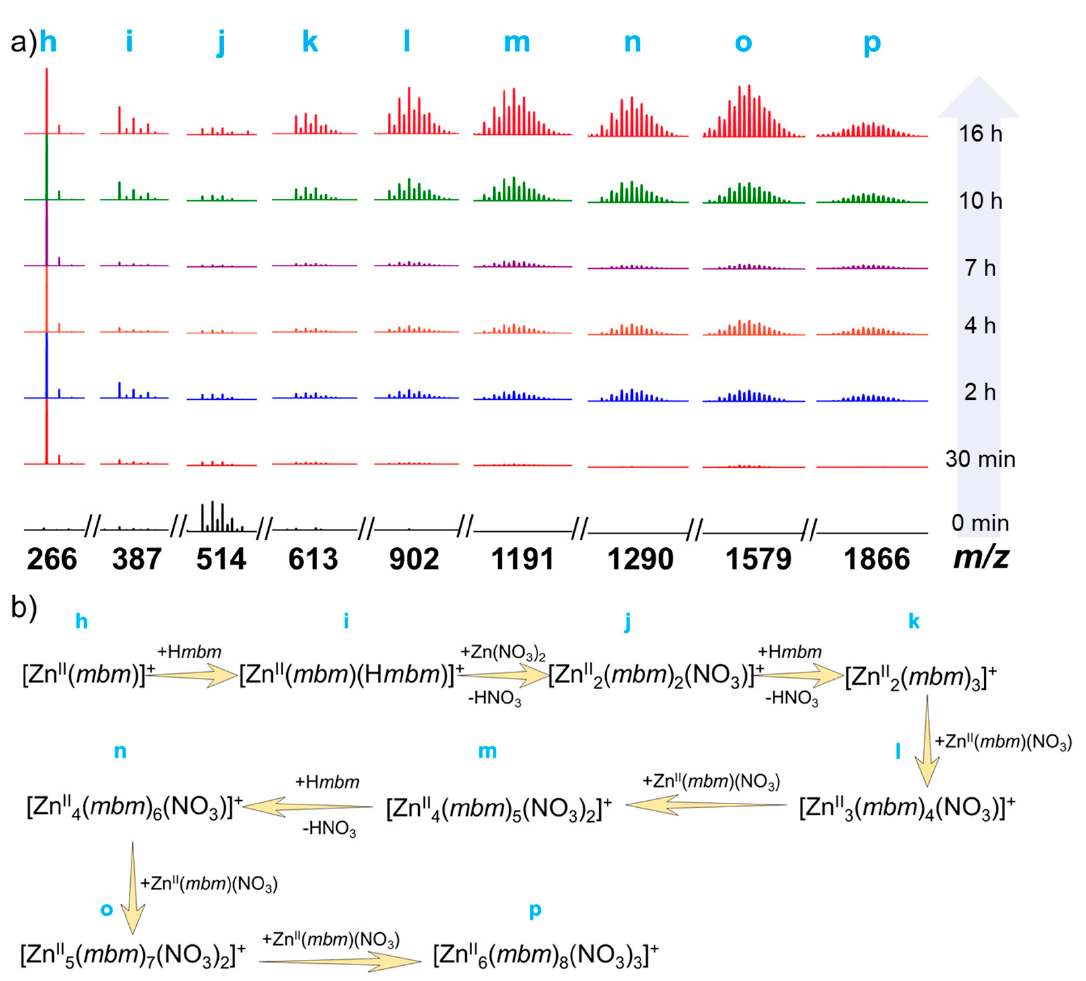
Figure 3. ( a ) The time-dependent HRESI-MS of the Zn6 formation process at different time periods (for clarity, the fragments l → p were amplified by a factor of five); ( b ) Schematic diagram of the gradual assembly mechanism of cluster Zn6 with time.